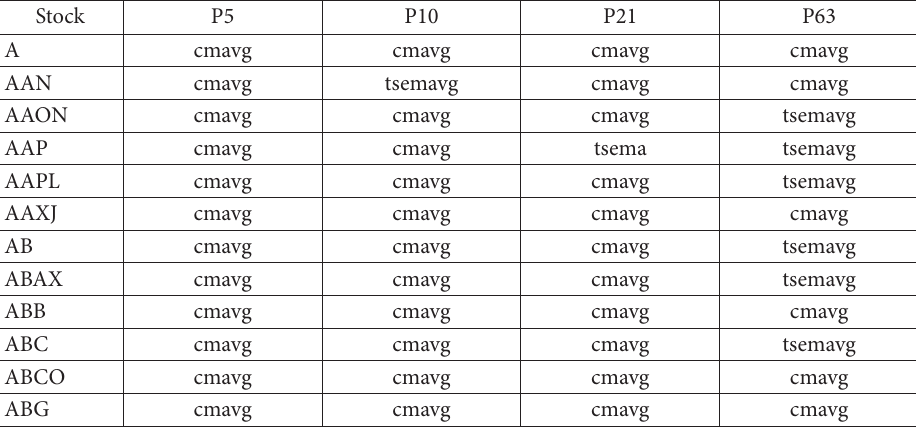
Table 5. Sample of non-summarised stock experiments. Table body cells contain the name of the most accurate moving average for that smoothness category Stock P5 P10 P21 P63 A